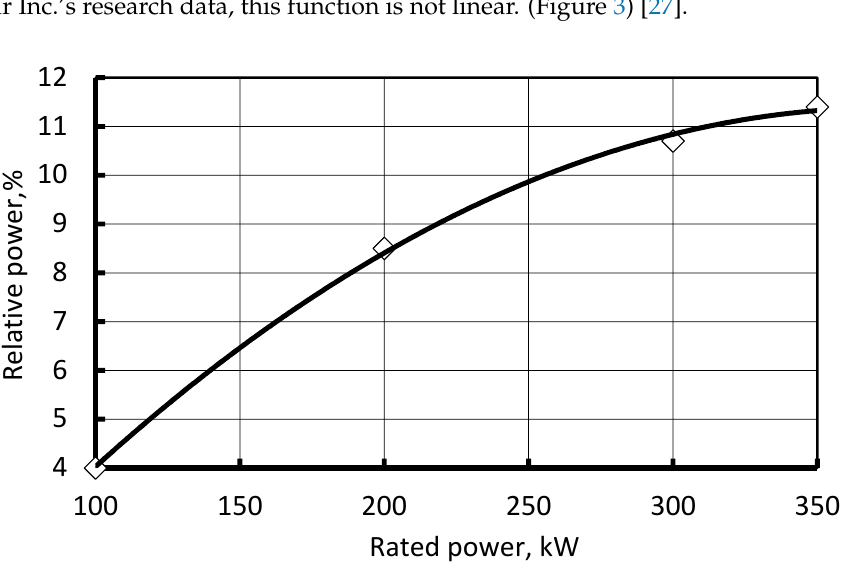
Figure 3. The relative power-turbine power as a function of rated power of an engine. Source: adapted from [27].